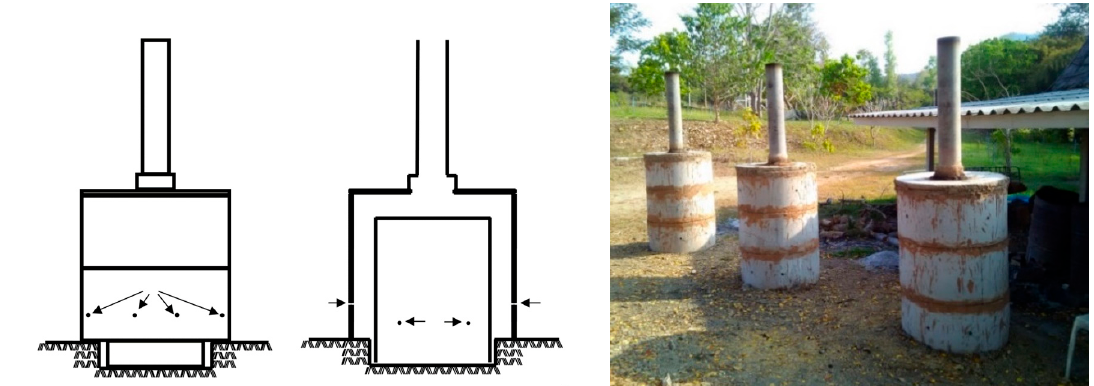
Figure 1. The Controlled Temperature Biochar Retort for Slow Pyrolysis Process.